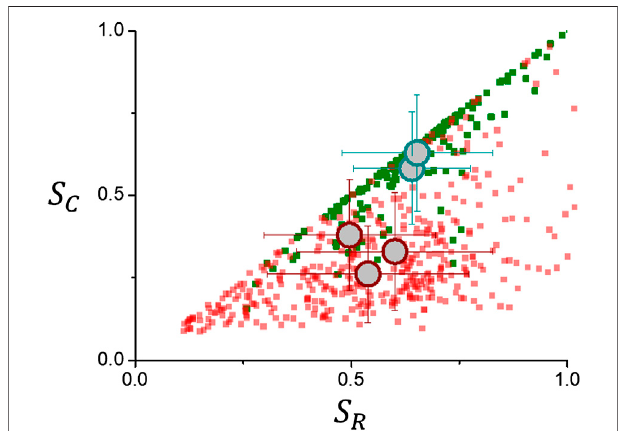
FIGURE 8 | Regularity measures for brain tumors. Circles represent averagevaluesformeningiomasandacousticschwannomas(green)andhigh grade gliomas and glioblastoma multiforme (red).